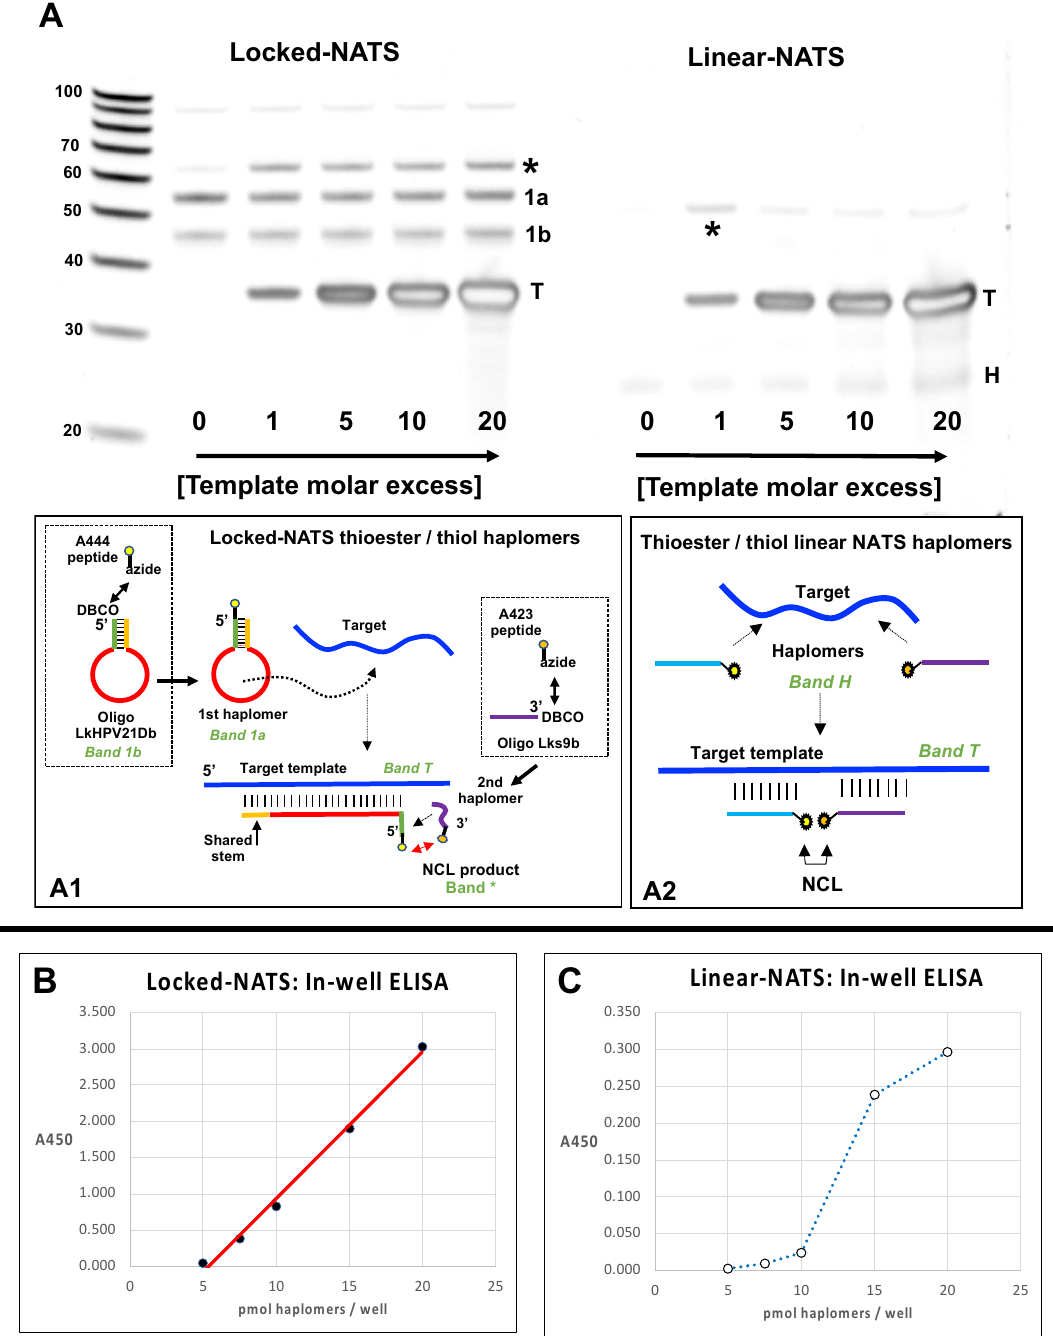
Figure 8. Locked (Lk) NATS strategy vs. Linear NATS with NCL assembly of a trastuzumab mimotope. ( A ) Denaturing 15% urea gels with Lk- and linear NCL reactions without template (0) and from 1–20-fold template excess. The Locked-NATS dibenzocyclooctyne (DBCO) oligonucleotide LkHPV21Db (DBCO-GCCACTGTGCTTTGTCTTTGCTT TTCTTCAGGACACAGTGGC) and the linear DBCO oligonucleotide 440 (Figure 1; DBCO-TTTCTTCAGGACACAGC) were conjugated with the trastuzumab azide- thioester mimotope fragment peptide A444 (Figure 1; Azide-SGGGQLGPYELWEL-[phenyl thioester]; the Locked-NATS DBCO oligonucleotide Lks9b (CACAGTGGC-DBCO) and the linear DBCO oligonucleotide 439 (Figure 1; GTCCAGATGTCTTTGC-DBCO) were reacted with the cysteinyl-azide mimotope fragment peptide A423 (Figure 1; CHGGGSK-azide). Conjugation reactions for the Locked-NATS oligonucleotides are depicted in dotted squares of subpanel A1. After conjugation reactions (as for Figure 2; 10-fold molar peptide excess), thiol reactions were reduced with 10 mM TCEP (Tris-(2-carboxyethyl) phosphine), and buffer-exchanged into PBS/1 mM TCEP/50 mM sodium ascorbate (PTA buffer). Paired Lk- and linear NATS conjugates were incubated for NCL reactions (3.75 µM; 1 h/22 °C) in PTA buffer with varying molar ratios of HPV DNA template Temp35.2